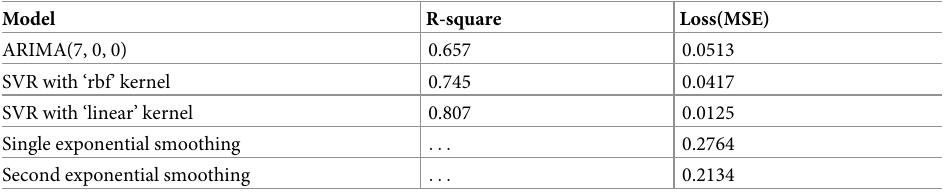
Table 4. Summary of ARIMA SVR and two simple statistical model